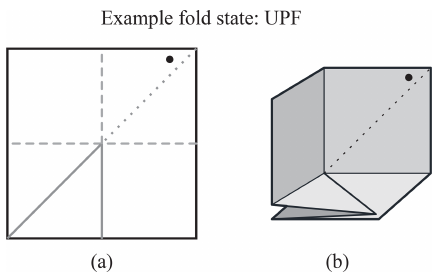
Figure 21. A crease pattern (a) with fold-angle assignment that will result in a UPF fold state (b) . The legend for fold-angle assignment is given in Fig. 8. The UPF state has at least two pairs of coplanar facets, one pair separated by a fully folded crease and another by an unfolded